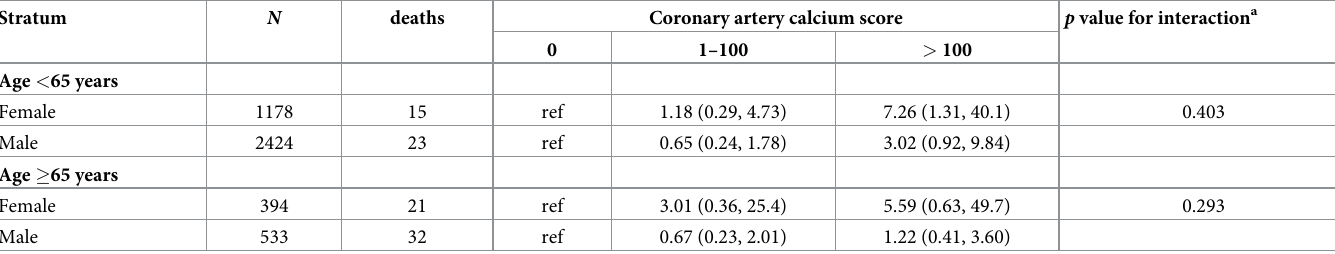
a Interaction between coronary calcium score and sex under age group. Model adjusted for age, body mass index, smoking, diabetes mellitus, systolic blood pressure, total cholesterol, high-density lipoprotein, estimated glomerular filtration rate and cardiovascular